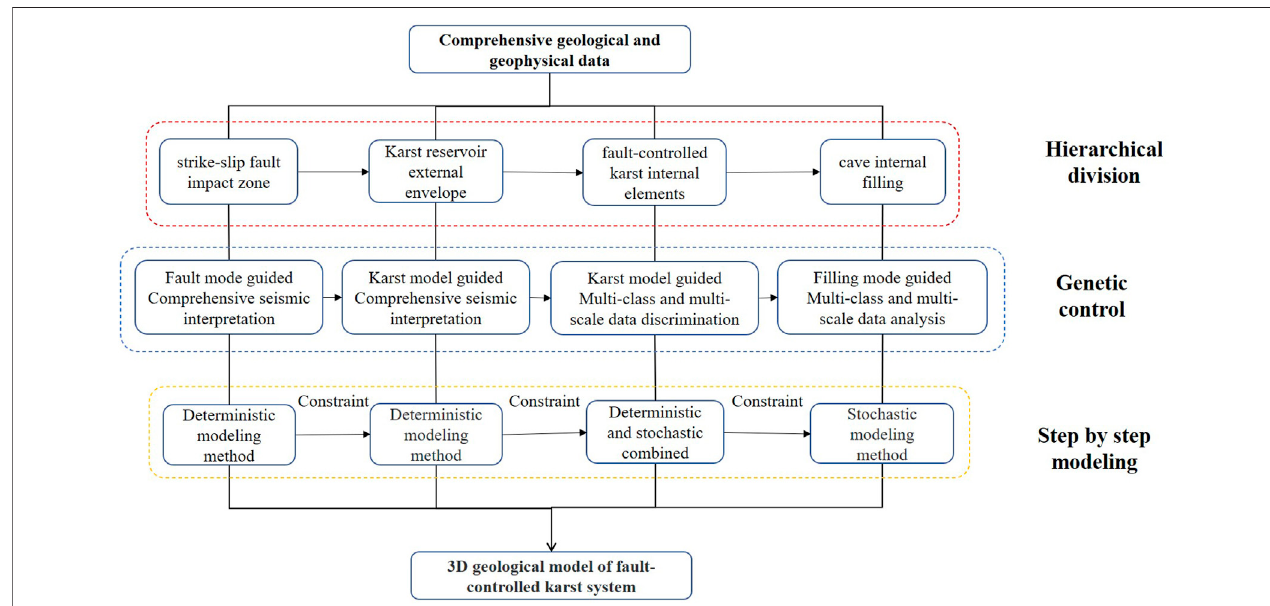
FIGURE 4 | Hierarchical modeling chart of the fault-controlled paleokarst